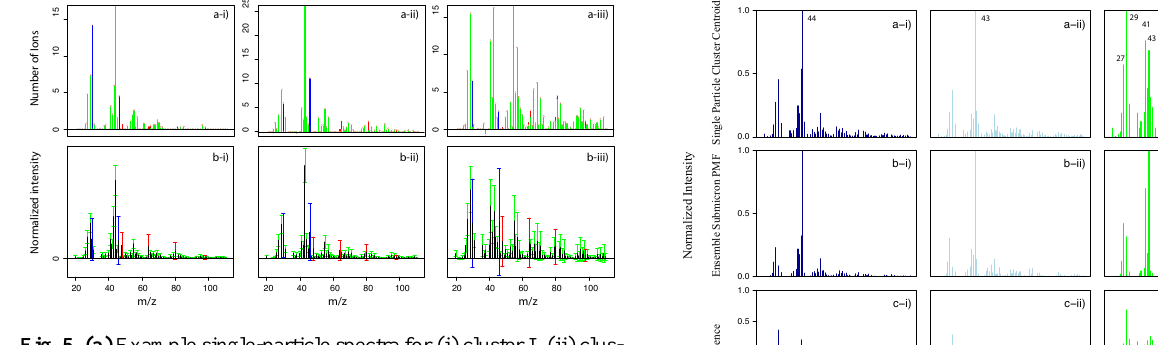
lower O/C than cluster I particles. The number fraction of cluster II particles increased at night and showed the opposite diurnal cycle to temperature (Fig. 7b), which is consistent with the previous findings that the less processed component accumulated and condensed onto preexisting particles during nighttime hours (Lanz et al., 2007). However, the correlation of cluster II particle number fraction with particle-phase ni- trate, whose formation is strongly dependent on temperature, was not found, suggesting that there might be other factors that affected the formation of cluster II particles. The